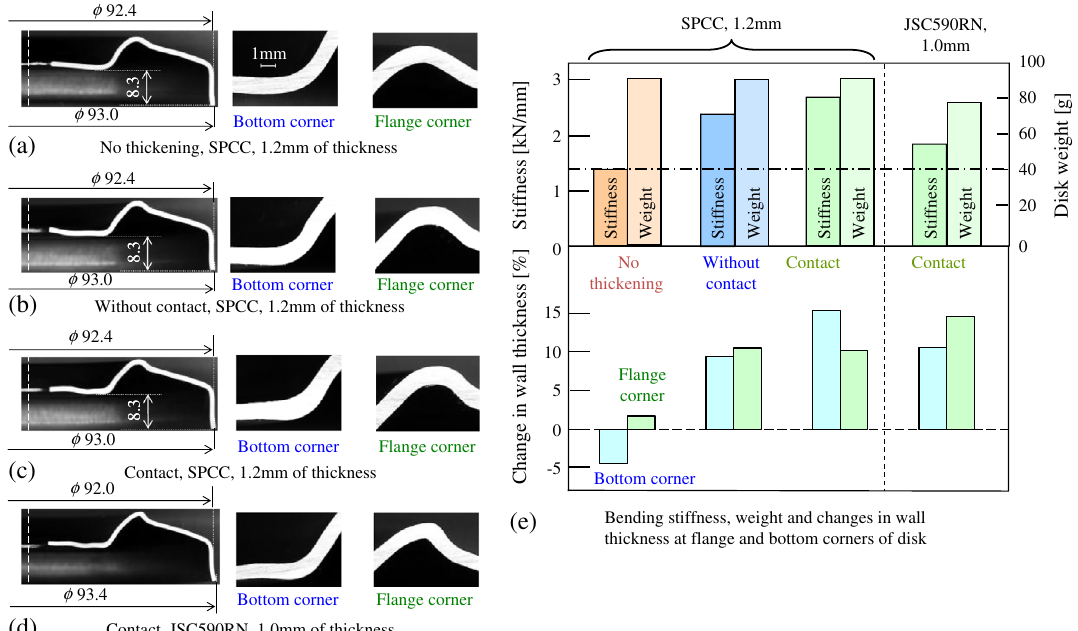
Figure 20. Cross-sections, bending stiffness, weight and changes in wall thickness at flange and bottom corners of